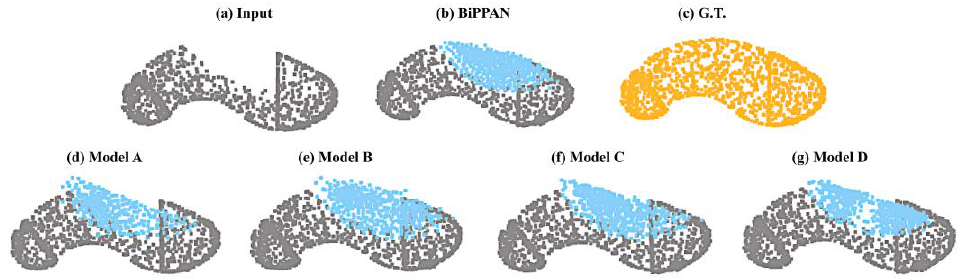
Figure 8. Comparison of point cloud completion results of the proposed network, baseline Model A, and Models B, C, D.